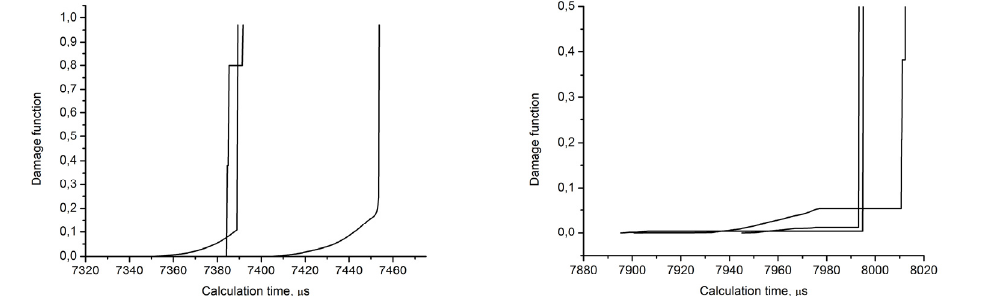
Figure 11: Damage function monitoring for several particles of the specimen which are in the region of a prospective dynamic influence in the composite with 15% content of hardening particles (a – in the case of friction on the loading border, b - in the case of ideal sliding on the loading